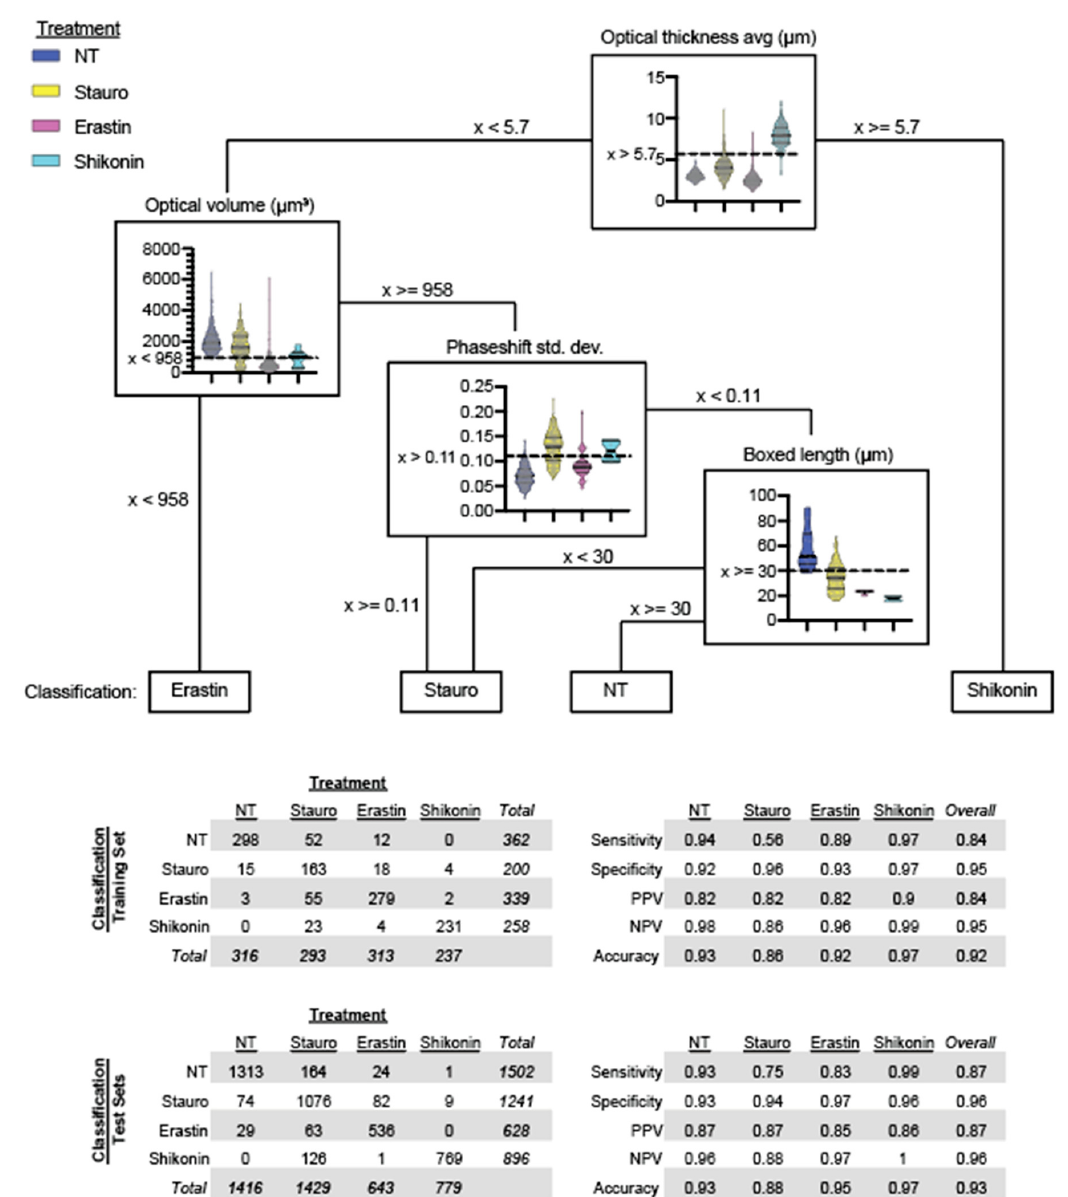
Figure 8. Four-node decision tree for classifying form of programmed cell death when healthy cells are included. Graphs depict all datapoints from Training Set not yet classified at each node. Dotted lines and “x” indicate threshold used to classify. Tables provide raw results and calculated metrics of accuracy for Training Set and combined Test Sets.